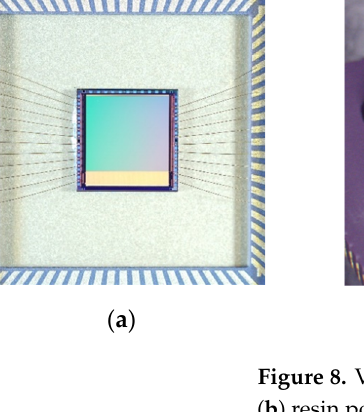
Table 1. Measured noise value of the two chips.